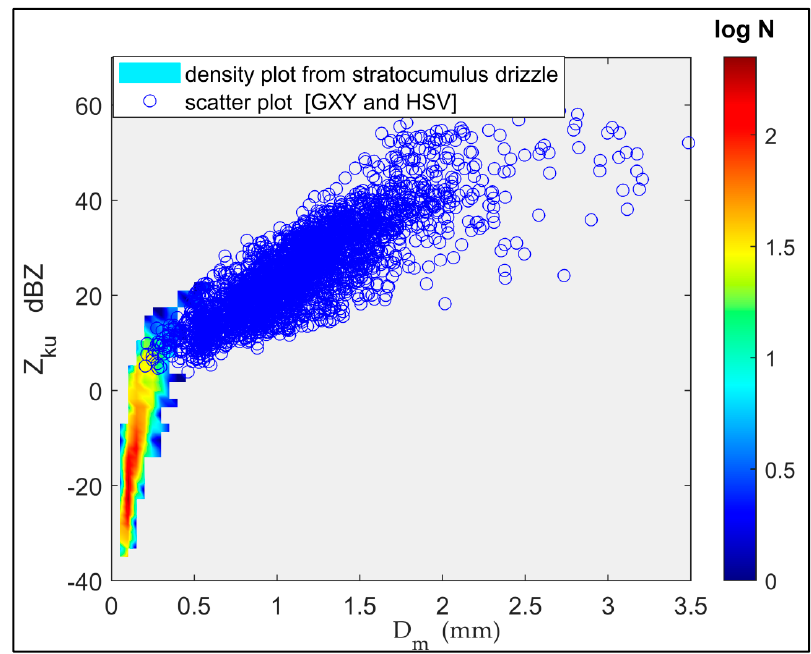
Figure 4. Scatterplot of the reflectivity at the Ku-band versus D m from stratocumulus drizzle (density-plot in color) and from all DSDs from GXY-HSV (blue points).